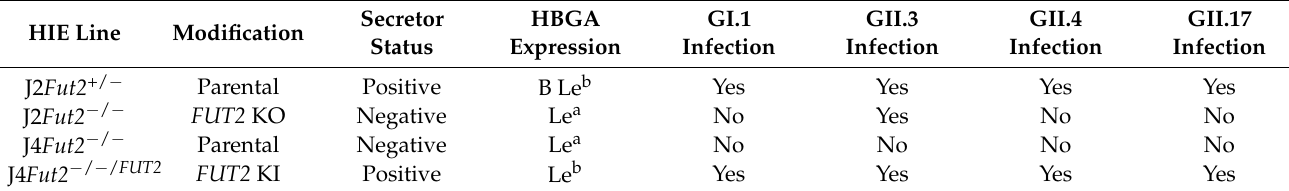
Table 3. Effect of genetic modification of FUT2 expression on HuNoV